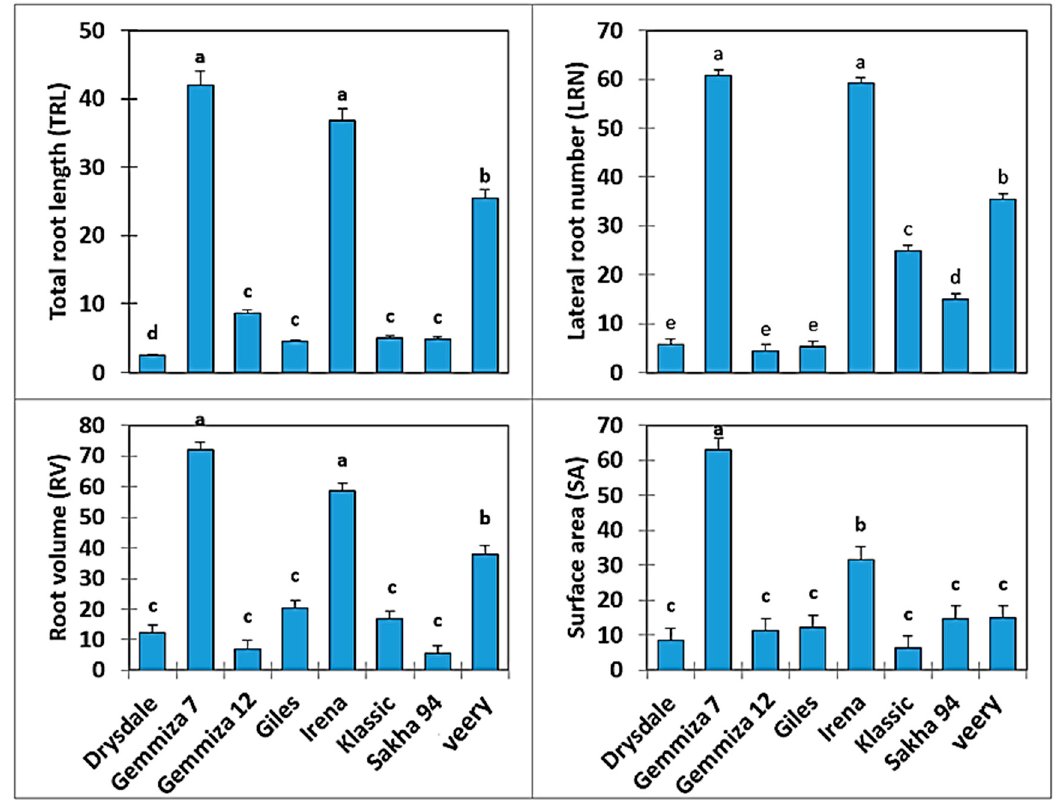
Figure 2. Relative drought effect of RSA traits for eight bread wheat genotypes at 14 DAT. Different letters within each parameter means significant difference at probability level of 0.05.